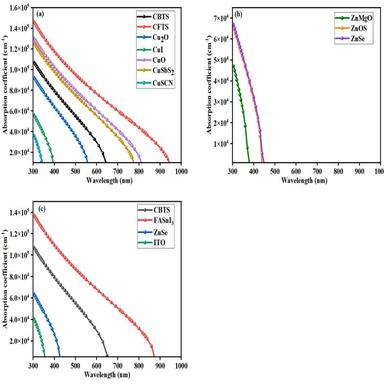
The graph of absorption coefficient (a) Copper based HTL (b) Zn based ETL (c) the final architecture.